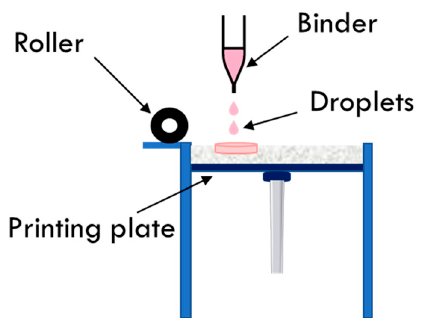
Figure 5. A schematic diagram illustrating BJ printer.